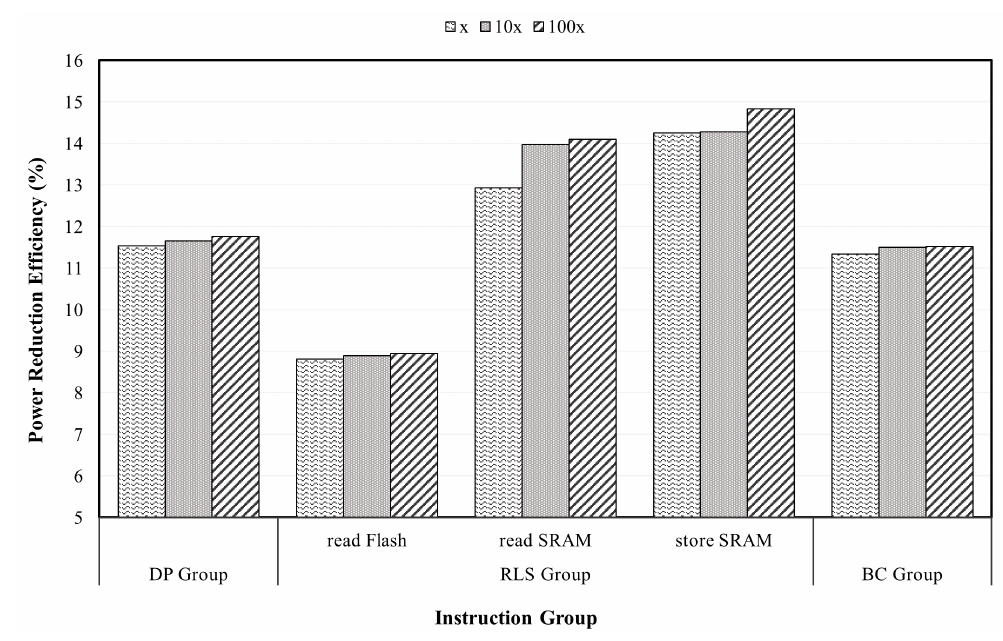
Figure 7. Code profiling result according to instruction